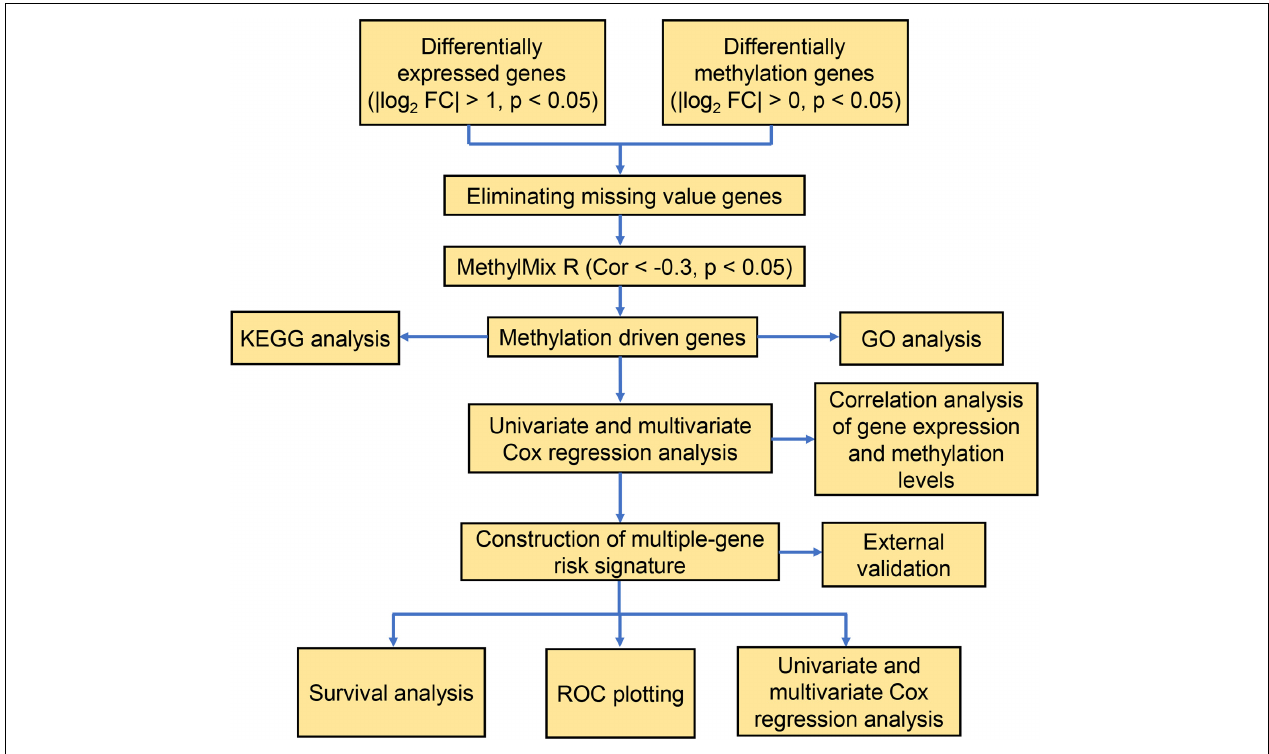
FIGURE 1 | A flow chart of the exploration of methylation-driven genes in thyroid